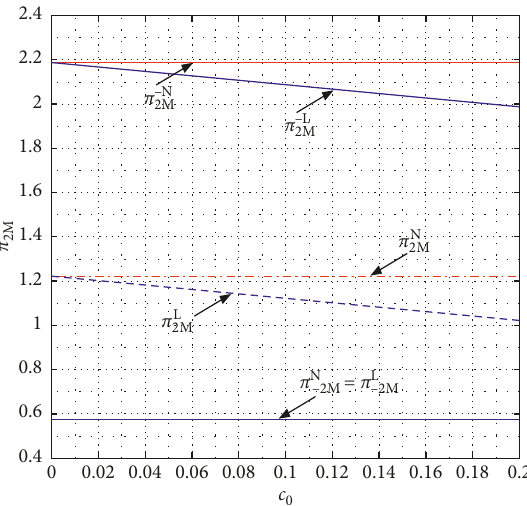
and π . Figure 11: Relationship between c 0 and π 3M 0 2M